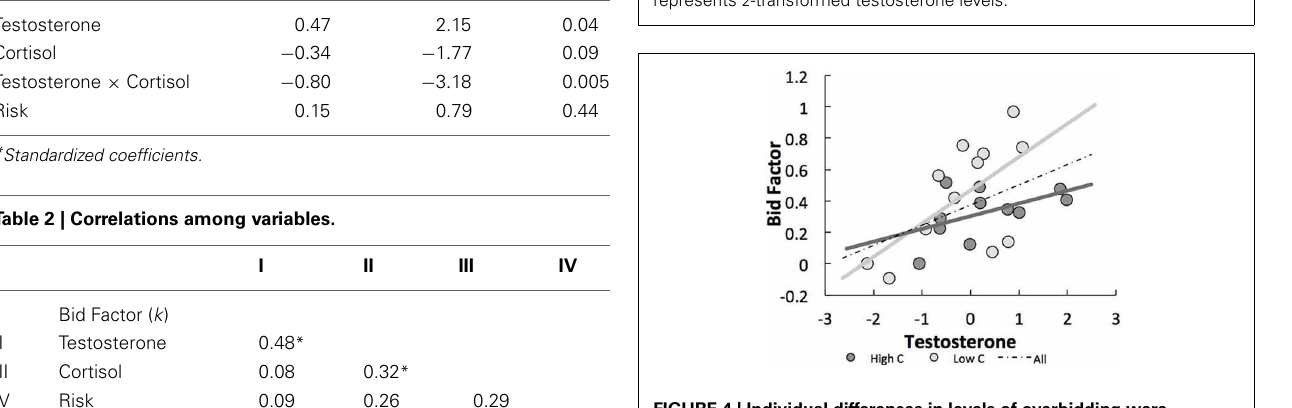
FIGURE 4 | Individual differences in levels of overbidding were correlated with self-report measures of affective responses to social ( r = 0 . 47, p < 0 . 02) but not monetary ( r = 0 . 15, p = 0 . 31)